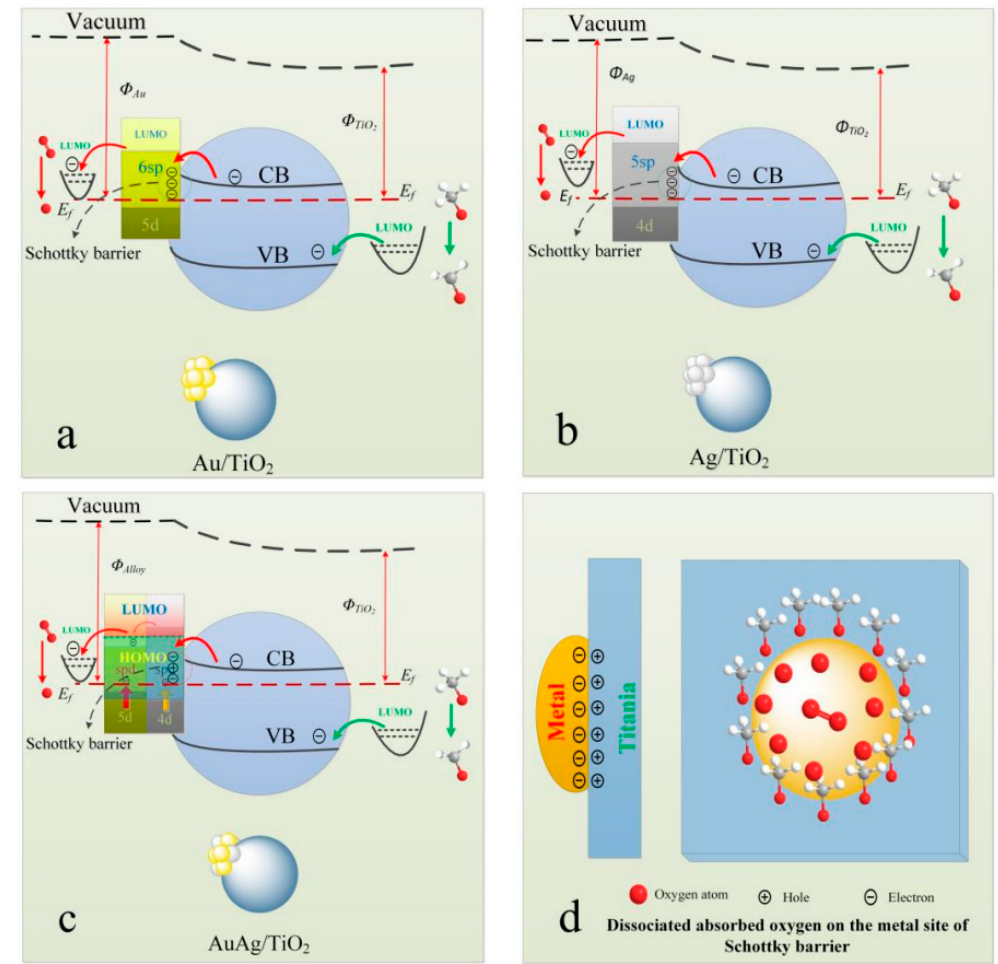
Figure 26. Schematic profile showing the formation of the Schottky barrier, the band bending, the electron transfer under UV irradiation and the oxygen dissociation on the metal surface near the perimeter. ( a – c ) Under UV irradiation, the excited electron from the valence band to the conduction band ejects to the metal, together with the excited electrons from the intraband and interband transition of the metal, making the metal surface more negative. The negative charge attracts oxygen and induces oxygen dissociation on the surface of the metal. The hole on the surface of titania captures electrons from the coordinated methoxy to give rise to the coordinated formaldehyde due to the higher redox potential of the hole. ( d ) Oxygen is dissociatively chemisorbed at the perimeter of the metal due to the negative charge in the metal site of the Schottky barrier. Methanol is dissociatively chemisorbed on the positively charged perimeter of the titania sites. Reprinted with permission from reference [177]. Copyright 2014 Royal society of chemistry.